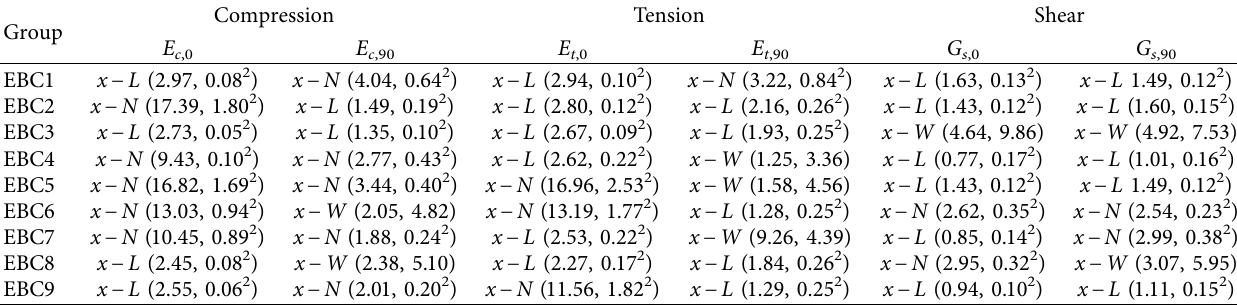
Table 4: The details of the best-fit distribution functions of modulus for EBC.